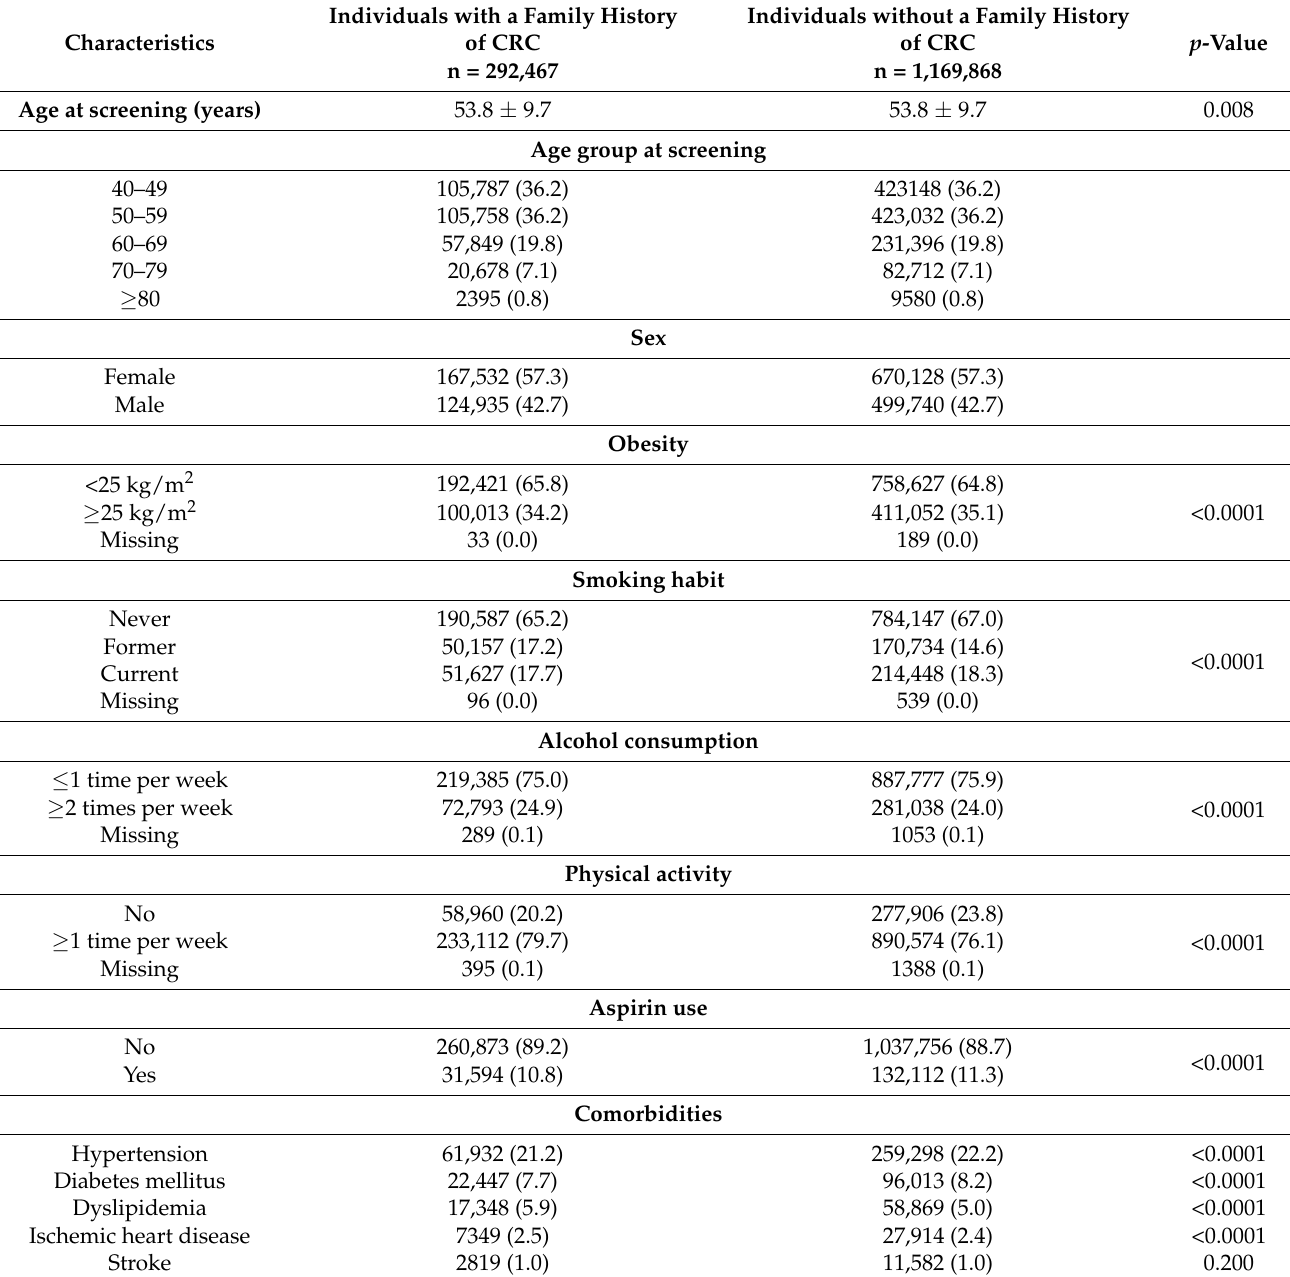
Table 1. Baseline characteristics of study participants according to family history of